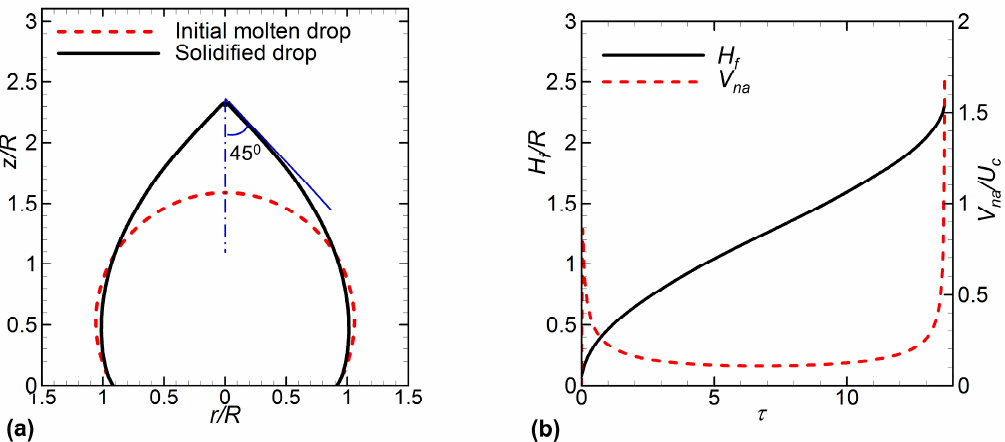
Figure 4. ( a ) Solidified drop profile after complete solidification (solid line) and ( b ) variation with respect to time of the average height H f of the solidifying front and the average solidifying rate V na normalized by U c . The parameters are the same as in Figure 3.